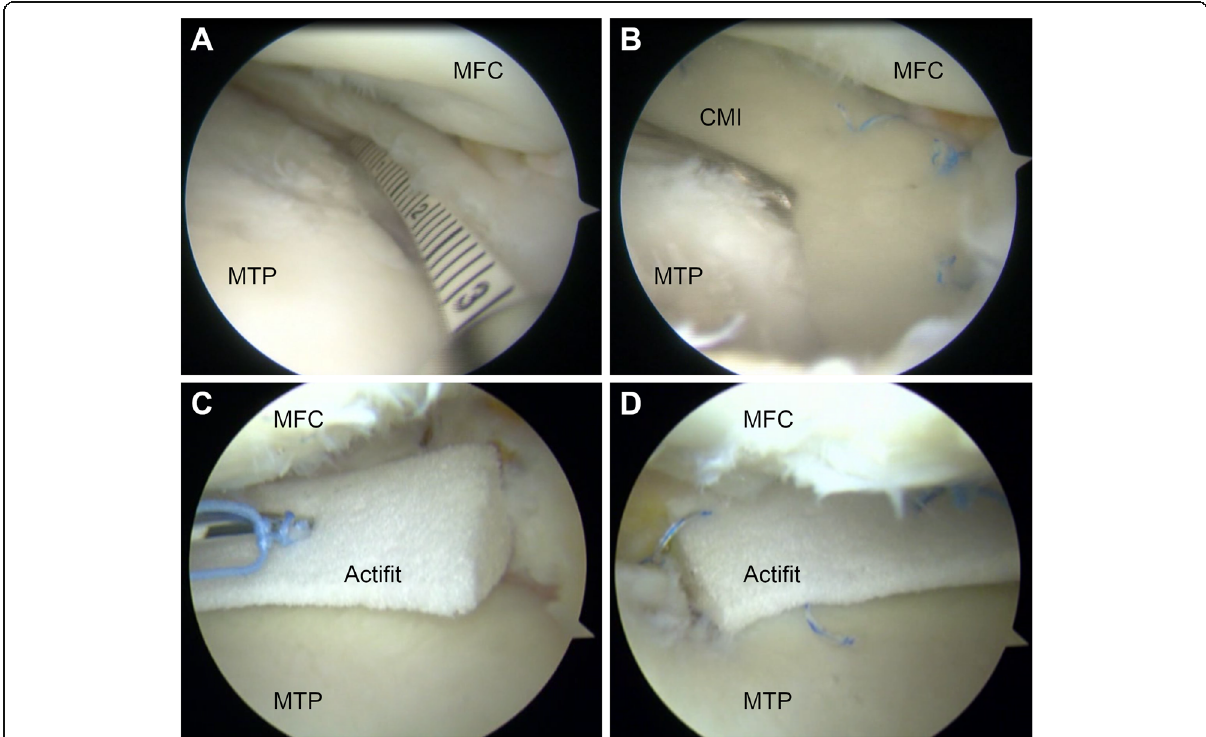
Fig. 4 Arthroscopic images of scaffold-based partial meniscal substitution. a) and b) Substitution of partial medial meniscus defect using the collagen meniscus implant (CMI; Stryker Corporation, Kalamazoo, MI, USA). c) and d) Substitution of partial medial meniscus defect using Actifit® (Orteq Sports Medicine Ltd., London, United Kingdom). a) Measurement of the defect size. b) CMI in situ. c) All-inside suture fixation of Actifit®. d) Actifit® in situ. MFC, medial femoral condyle; MTP, medial tibial plateau. (Acknowledgement to Stefano Zaffagnini, who provided the